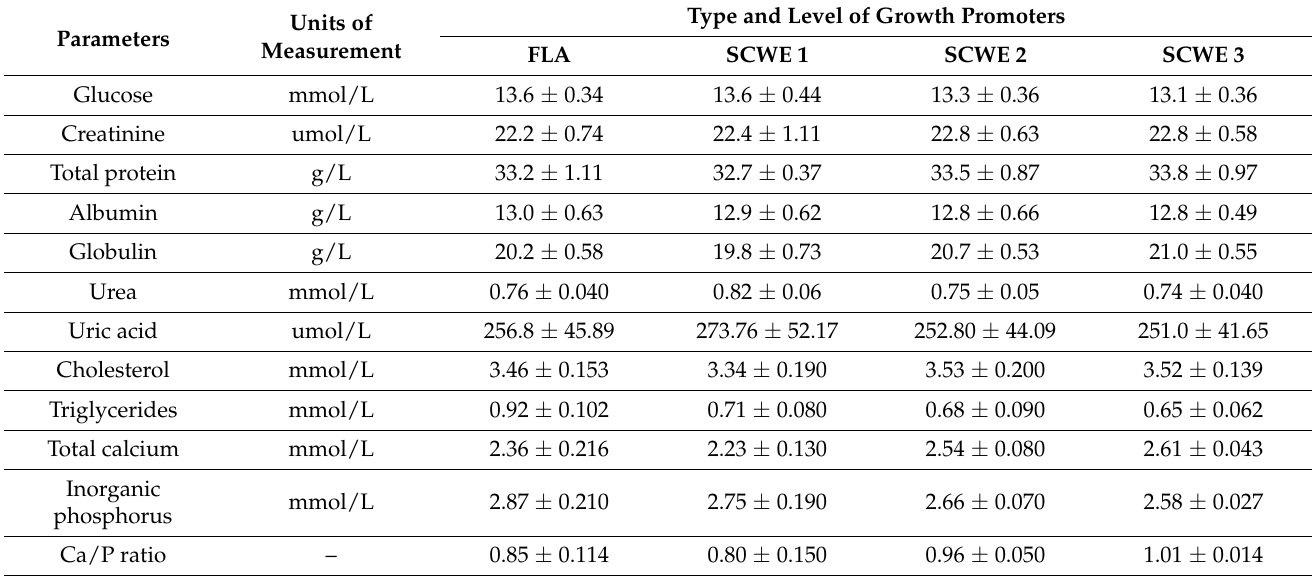
Table 8. Biochemical parameters of blood serum of broiler chickens (36